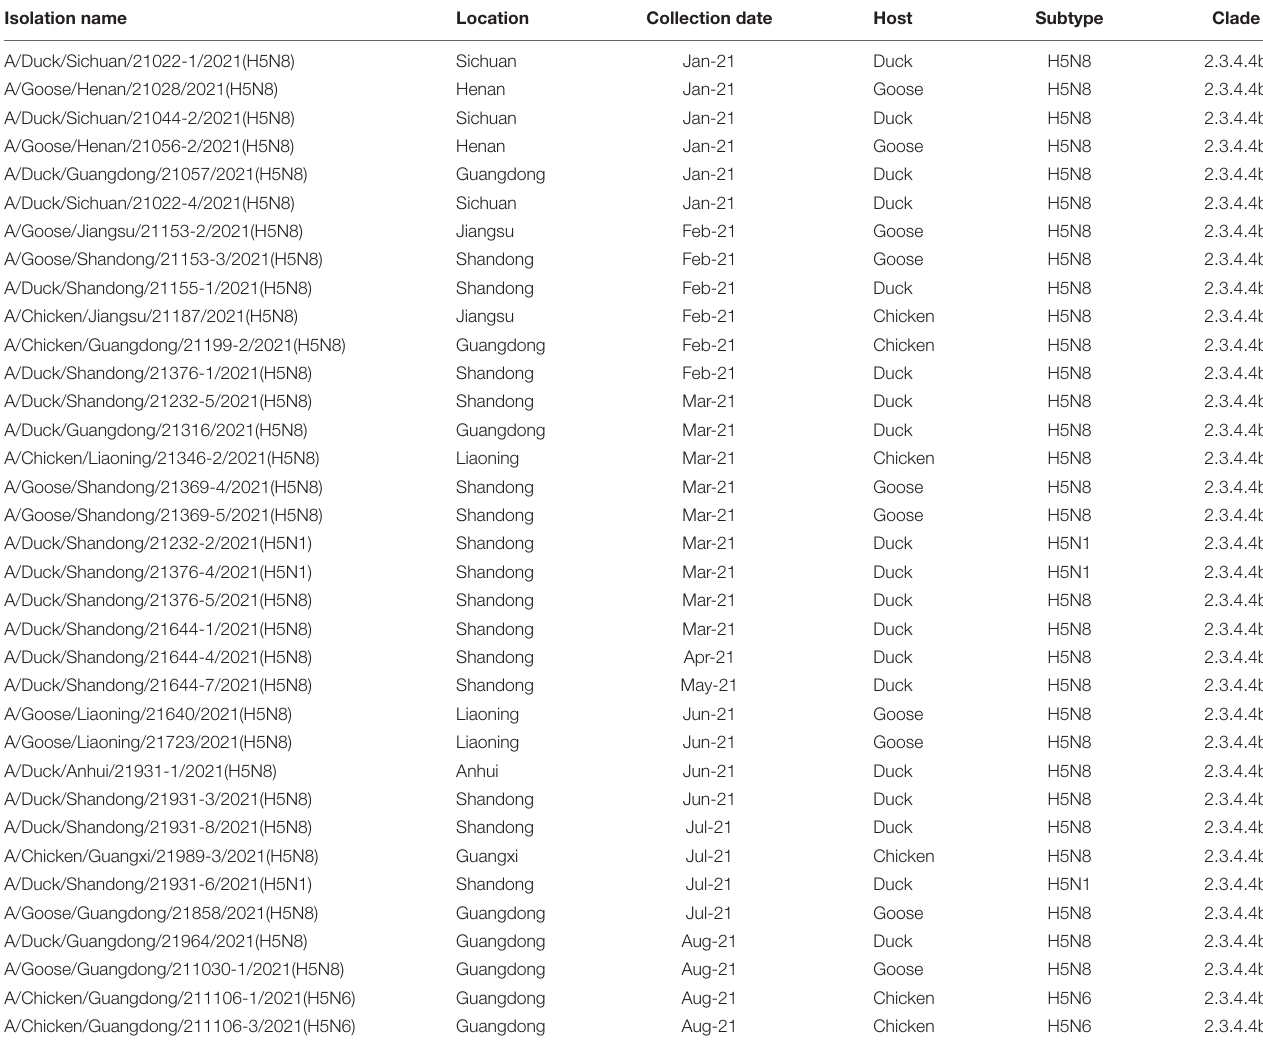
TABLE 1 | Highly pathogenic avian influenza H5 subtype viruses isolated from January 2021 to August